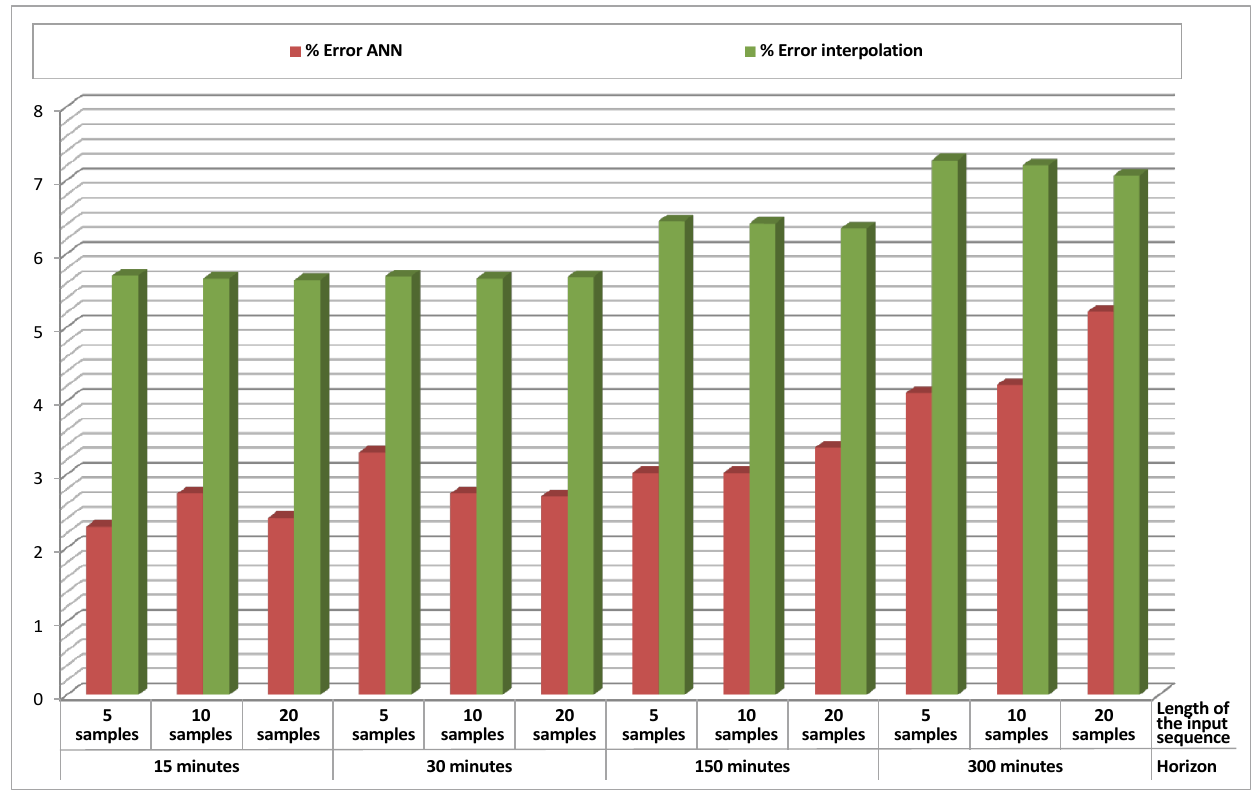
Figure 9. Data prediction results (% error ANN/% error interpolation) for temperature in Sensor 3, using temperature in Sensor 1 as an